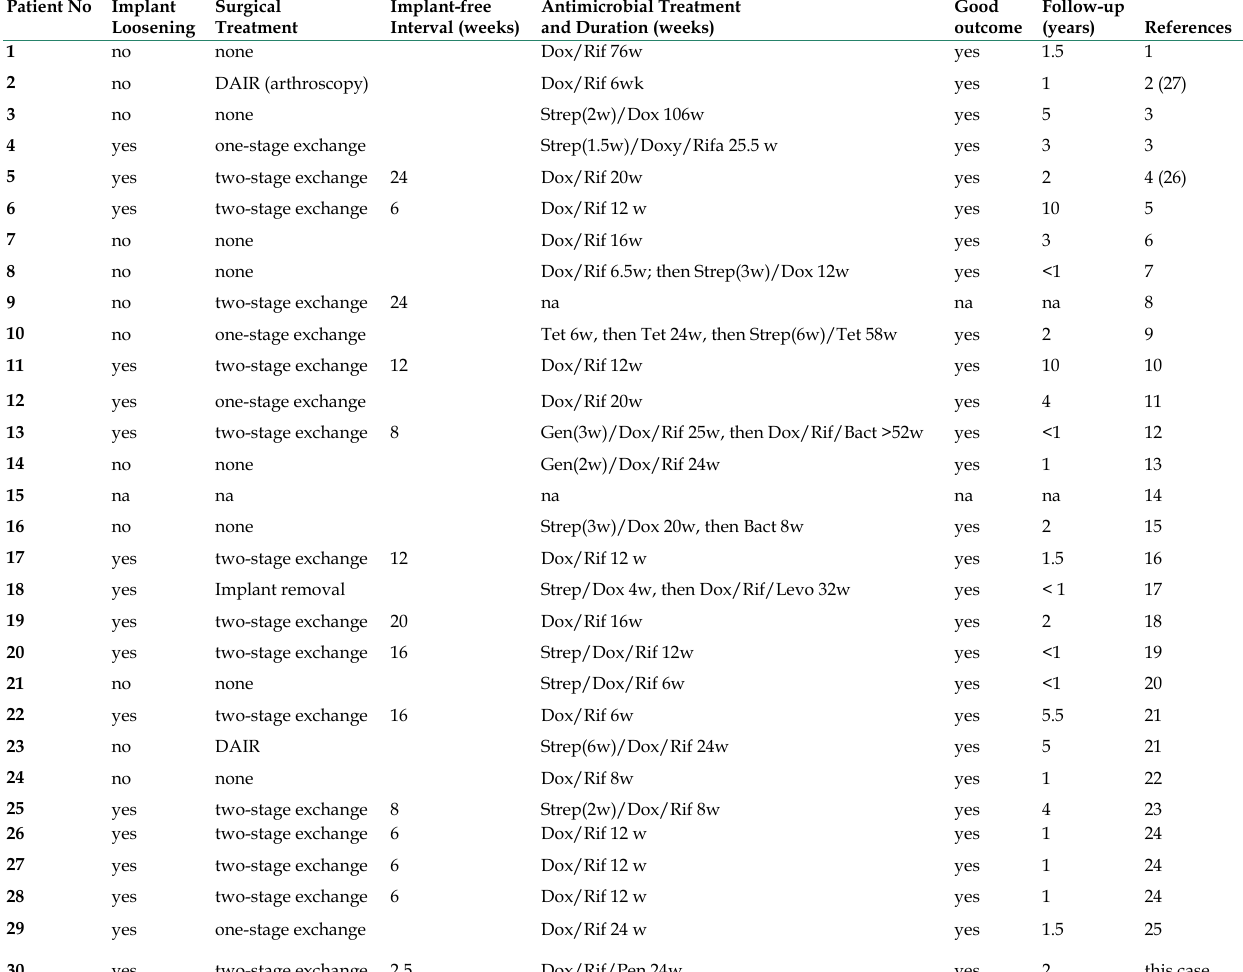
Table 2. Treatment and follow-up. Patient No Implant Surgical Loosening Treatment